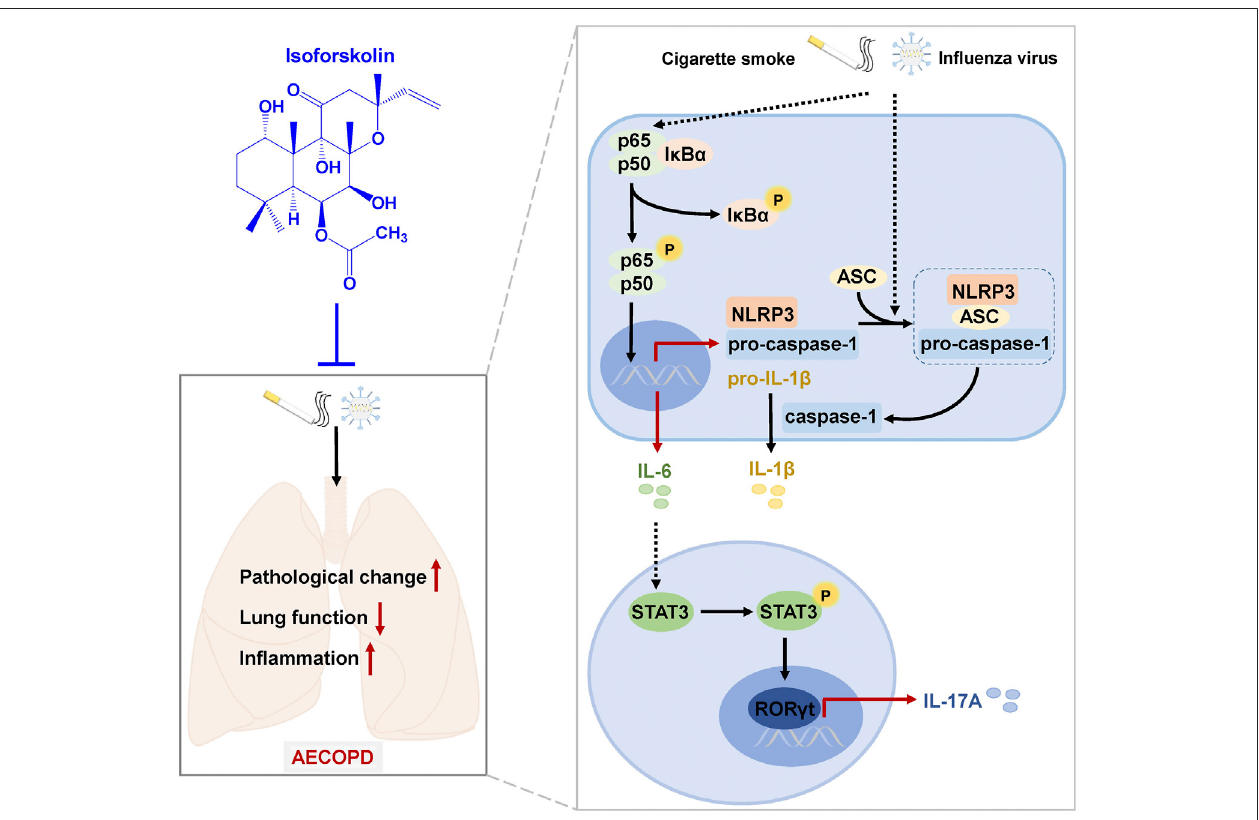
FIGURE 9 | A schematic diagram of the potential mechanisms by which ISOF treatment alleviates AECOPD in vivo . AECOPD model mice induced by cigarette smoke exposure and H1N1 virus infection have decreased lung function and increased pathological injury and in fl ammation, as well as activated NF- κ B signaling and NLRP3 in fl ammasome and increased Th17 cells and IL-17A level in lung tissues. ISOF treatment attenuates the phosphorylation of NF- κ B and the activation of NLRP3 in fl ammasome and decreases Th17 cells and IL-17A level in lung tissues, which could contribute to the decreased in fl ammatory response and improved lung function in AECOPD model mice. Thus, ISOF is a promising candidate for the prevention and treatment of